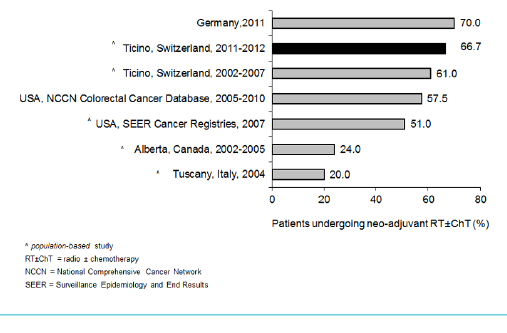
Figure 5: QI12. Proportion of patients with colon cancer and AJCC TNM stage II (T3–T4, N0, M0) high-risk or III (any T, N+, M0) re- ceiving adjuvant chemotherapy: comparison between southern Switzerland and other